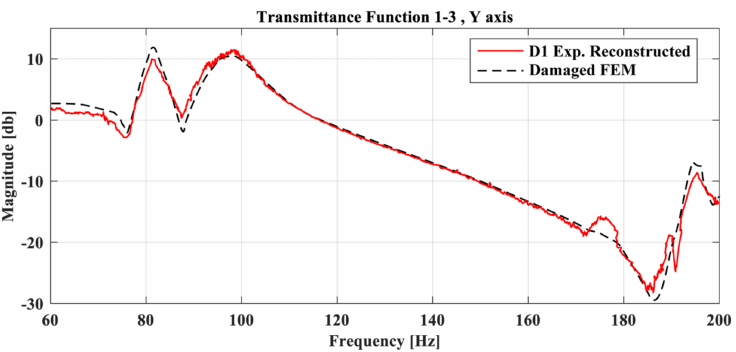
Figure 15. Transmittance Functions of the Damaged FE model and D1 case between accelerometer 1 and 3 at Y‑axis.